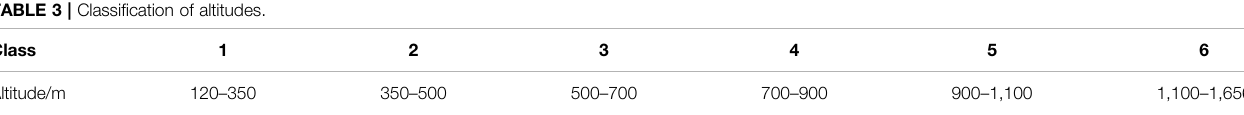
TABLE 3 | Classi fi cation of